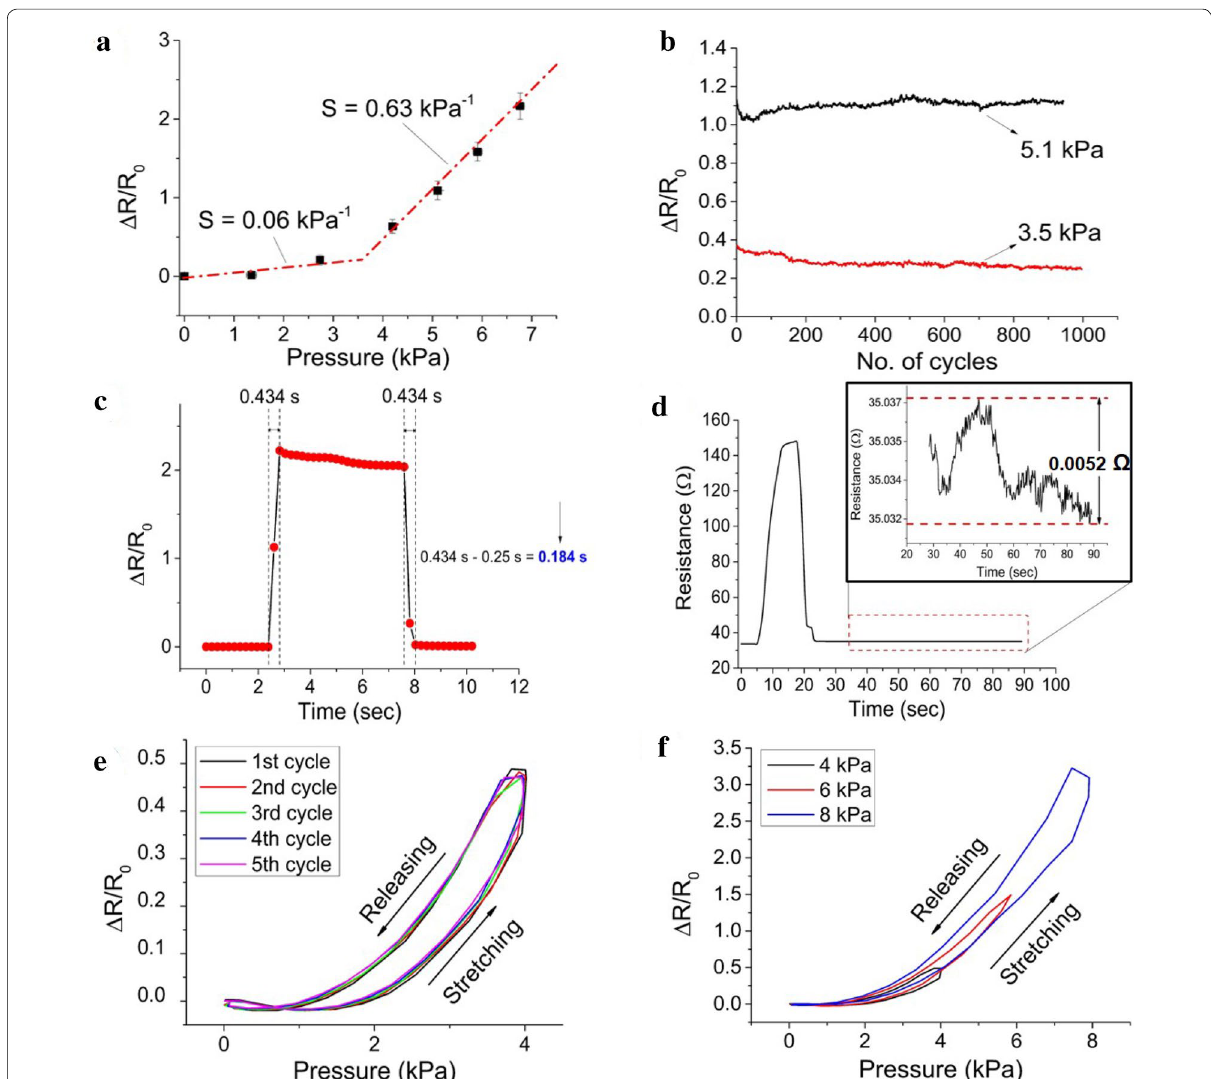
Fig. 7 Performance evaluation of the fabricated pressure sensor: a measured relative change in resistance as a function of applied pressure in which two distinct regions were identified, resulting in sensitivities of 0.06 kPa − 1 and 0.63 kPa − 1 for the pressure ranges of 0 kPa to 3.5 kPa and 3.5 kPa to 6.8 kPa, respectively, b the relative change in resistance in response to 1000 cycles of loading with 5.1 kPa and 3.5 kPa, c the response delay time and relaxation time of the sensor when 6 kPa was applied and removed in a speed that simulates the infant’s natural NNS (peak pressure reached within 0.25 s), d the noise level in resistance of the sensor when the sensor was relaxed immediately after a pressure load application, which was used to calculate the sensor’s minimum measurable pressure as 2.47 Pa, e the hysteresis curves of 5 consecutive cycles of 4 kPa loading, and f the hysteresis curves under 4 kPa, 6 kPa and 8 kPa